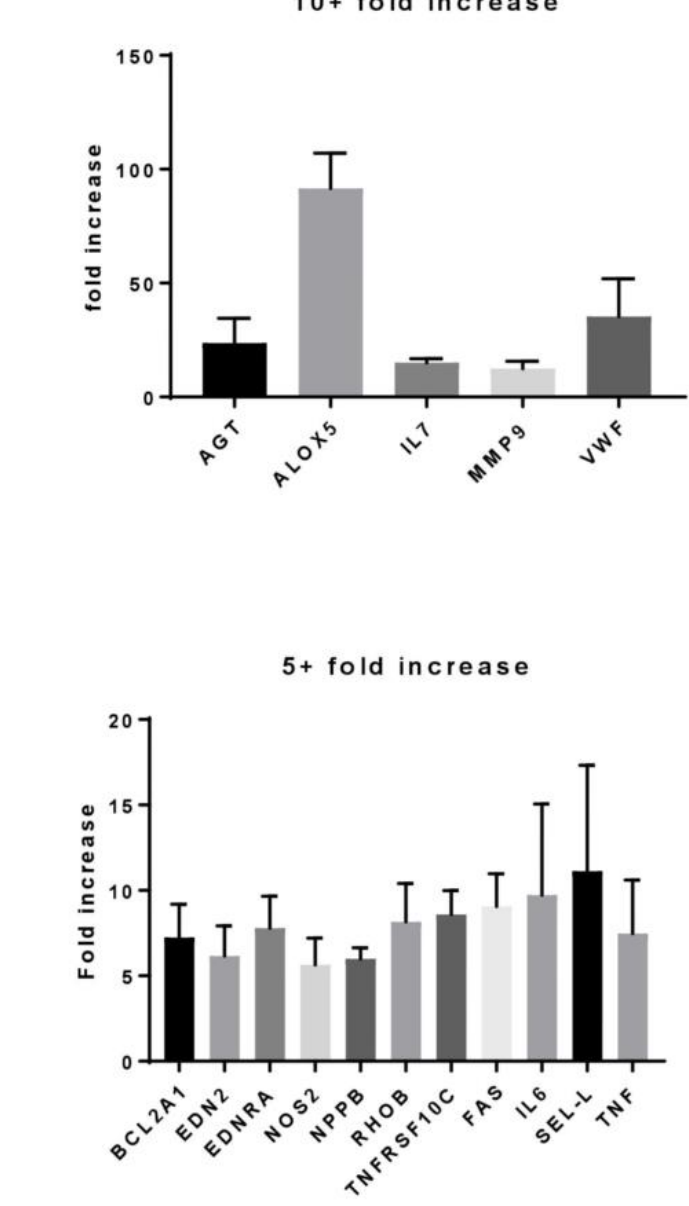
Figure 3. MF radiation induced changes in hBMEC gene expression. Cells were irradiated with 6 Gy MF. Four h after exposure, RNA was isolated and changes in gene expression were analyzed by RT-PCR array. Changes depicted were compared to nonirradiated hBMEC control cells. Error bars represent standard deviation. ( A ) Increased gene expression 10-fold or greater. ( B ) Increased gene expression 5-fold or